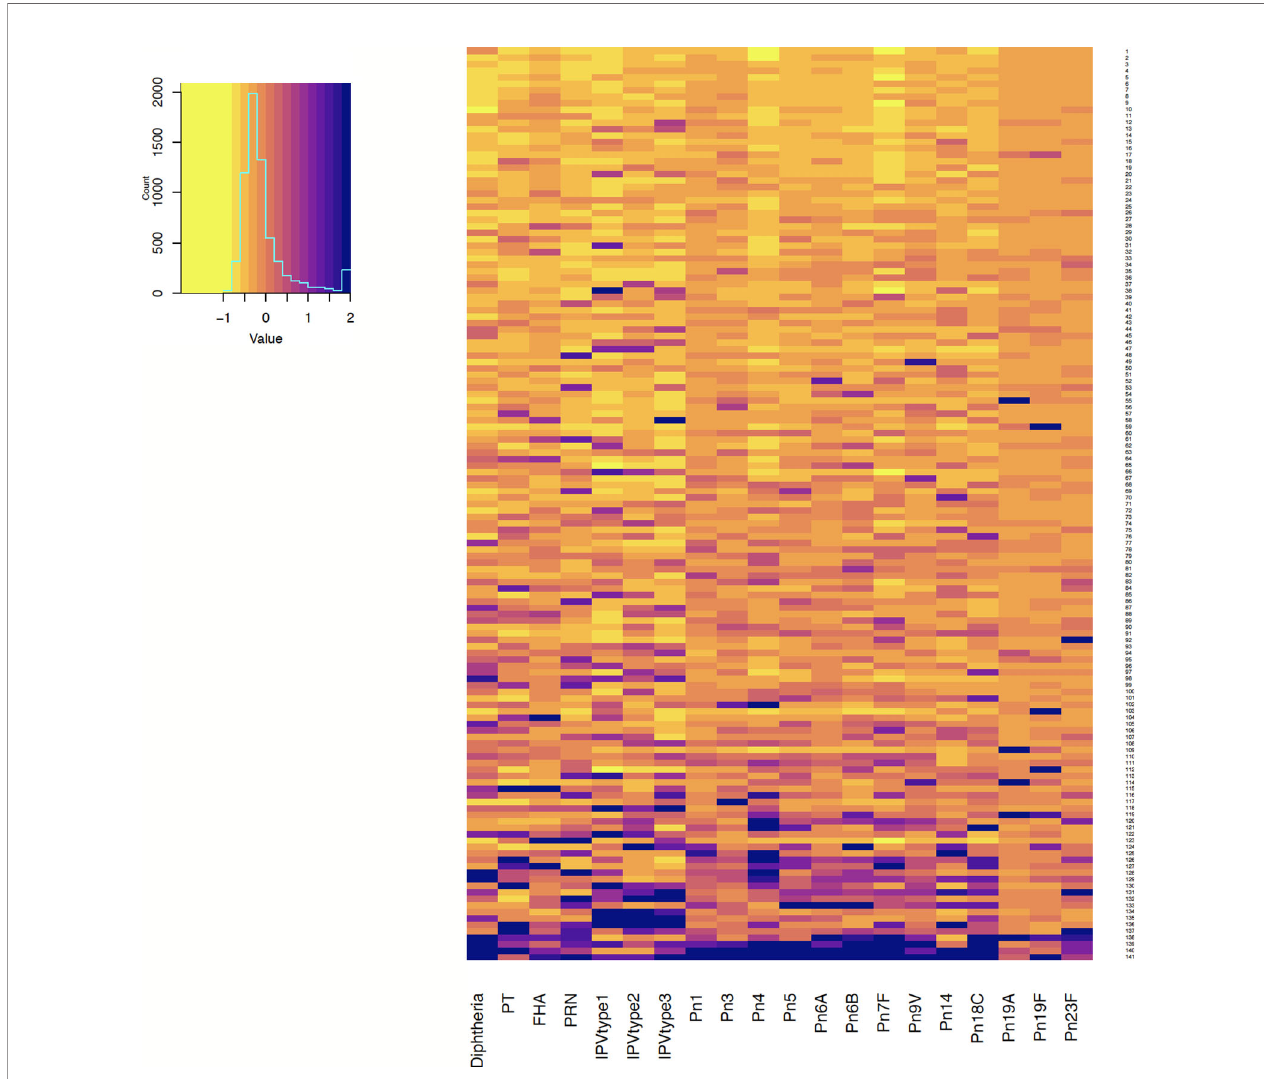
FIGURE 2 | Antibody responses to vaccine antigens measured 7 months after 6-month vaccinations (at 13 months of age, for persistence of responses) in 141 participants. Each row depicts one participant with the colour in each column representing the ‘ scaled ’ [(individual vaccine response - mean vaccine response)/standard deviation] vaccine antibody response in that individual. PT, pertussis toxin; FHA, fi lamentous haemagglutinin; PRN, pertactin; IPV, polio; Pn, pneumococcal